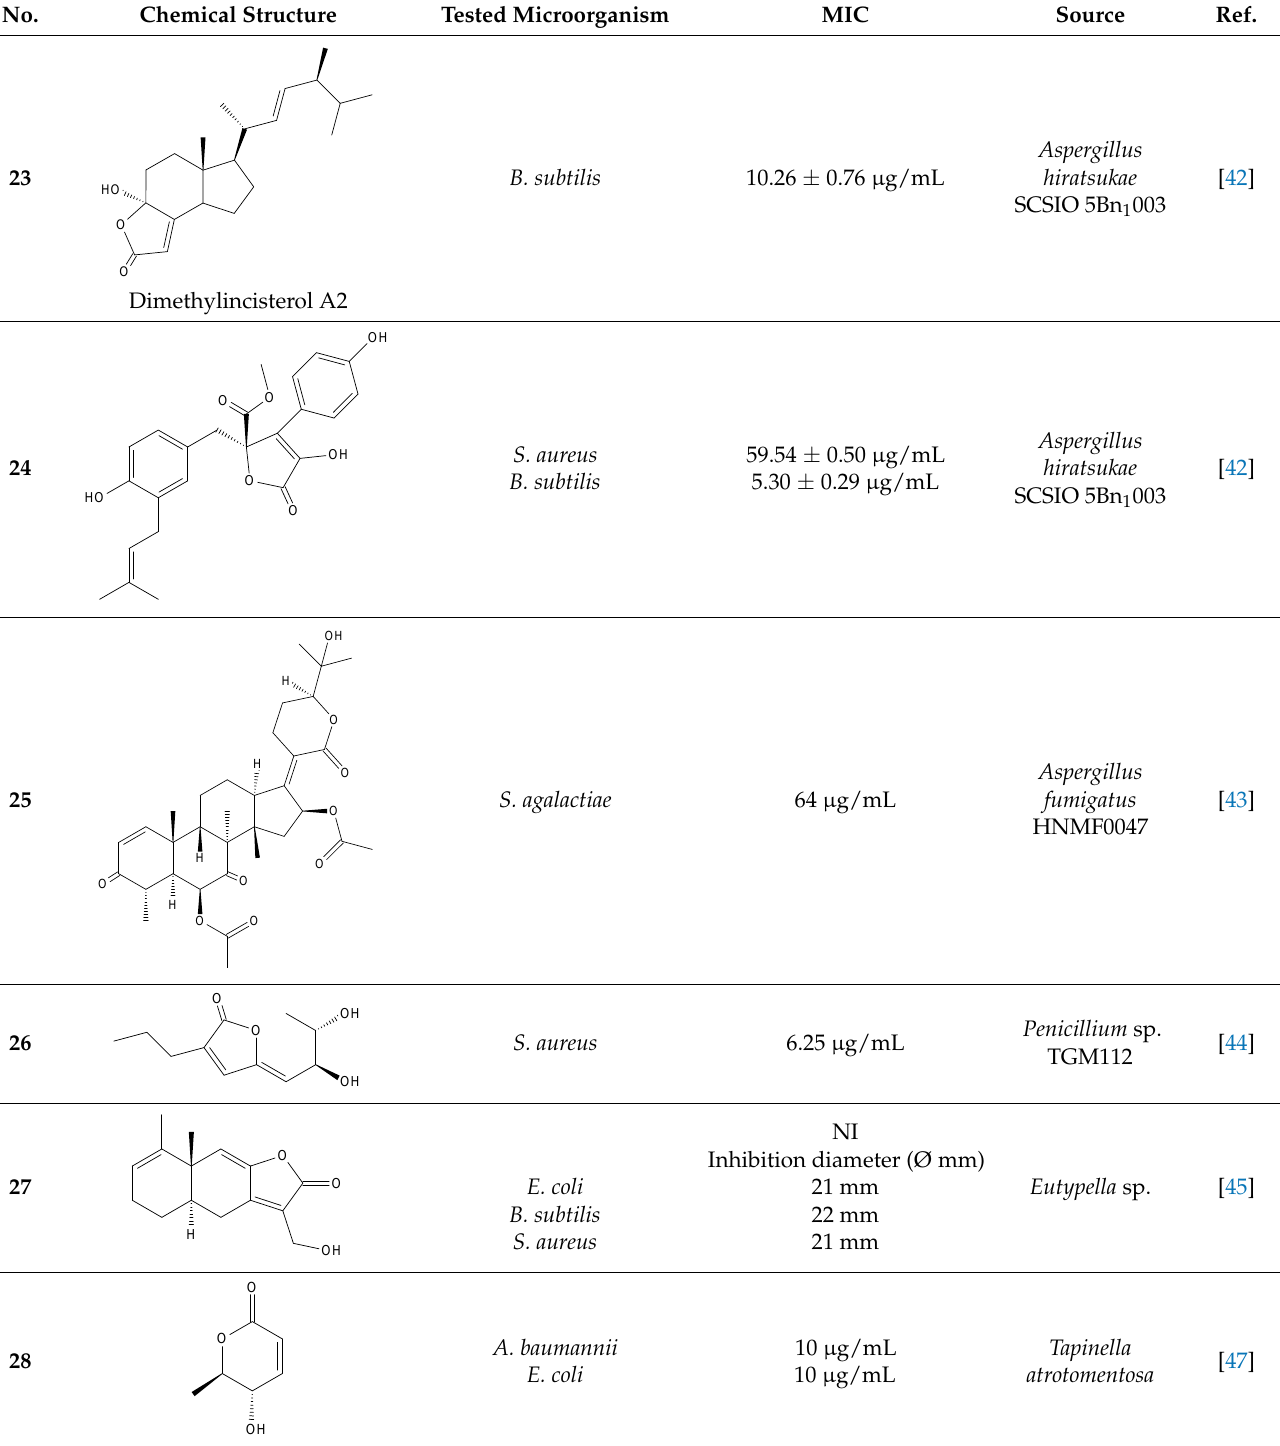
Table 2. Antimicrobial activity of lactones isolated from other sources.